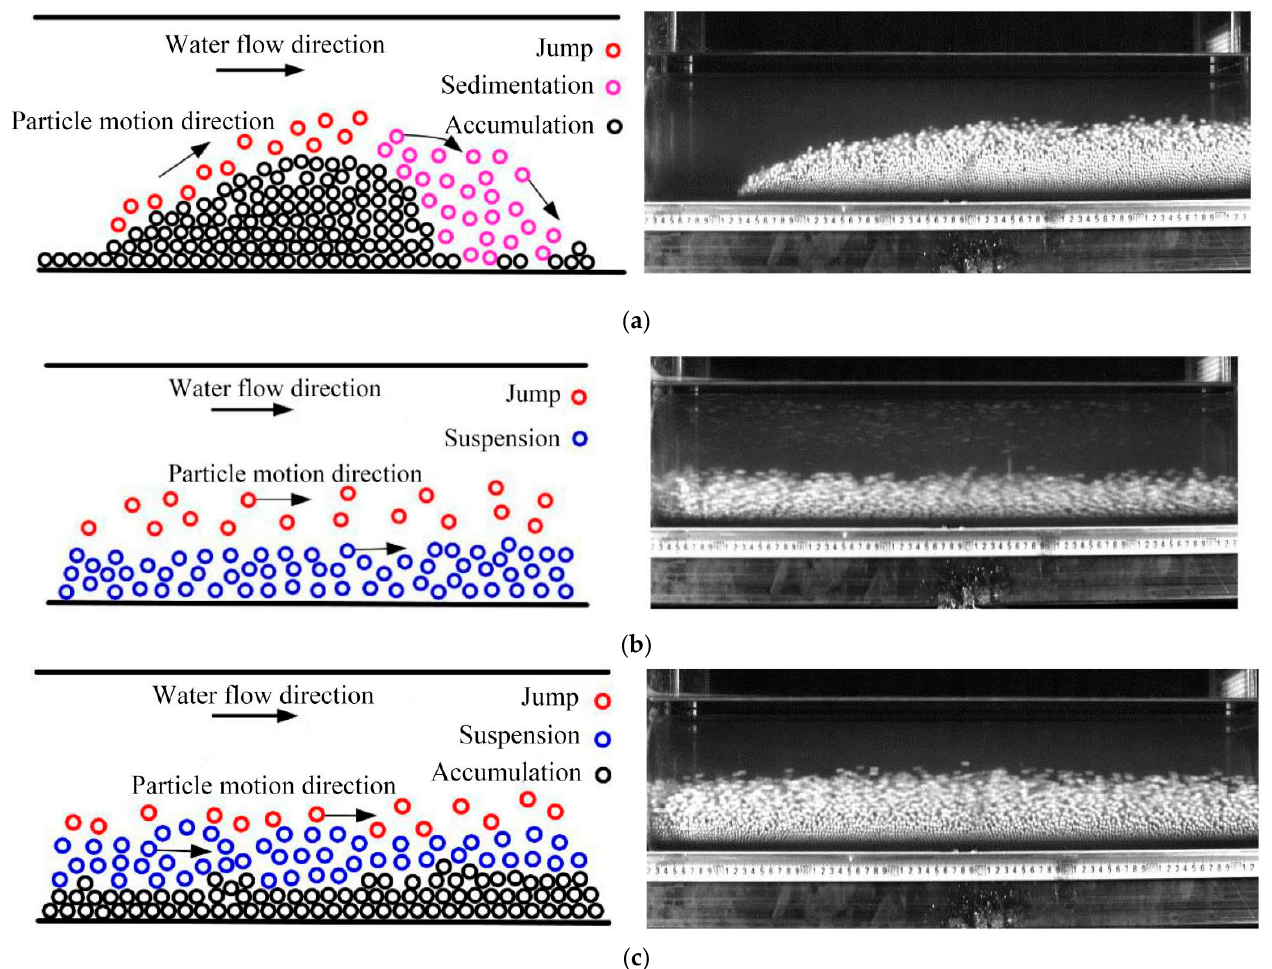
Figure 6. Motion state diagram of coarse particles in a pipeline. ( a ) Aggregate conveying; ( b ) Jump conveying; ( c ) Suspension conveying